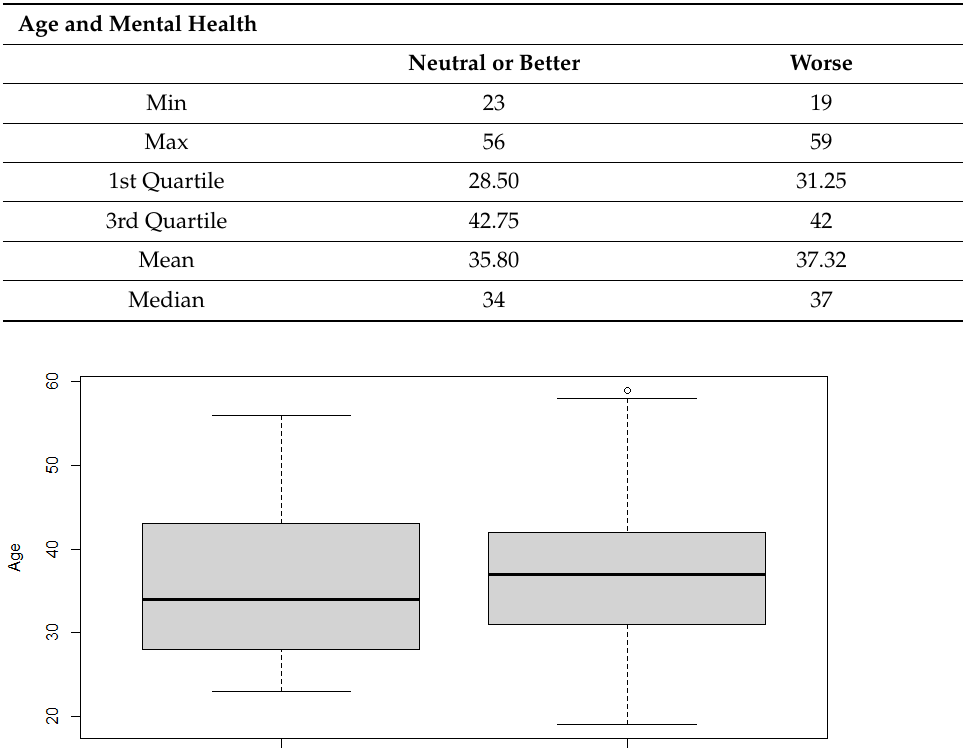
Table 6. Shapiro and Levene’s Test.